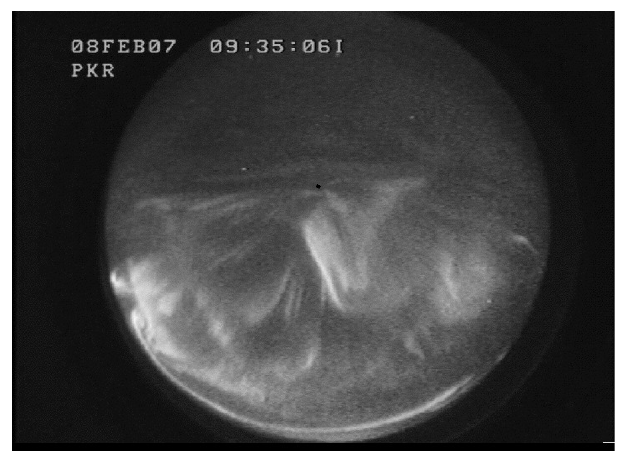
Fig. 5. All-sky camera image taken from 09:35:06UT, showing the large-scale auroral context of this NEIAL event. The location of the PFISR beam at 100km altitude is shown as the small black box near the center of the image. This shows the tall auroral rays that were present during this event. (North is down and east is to the